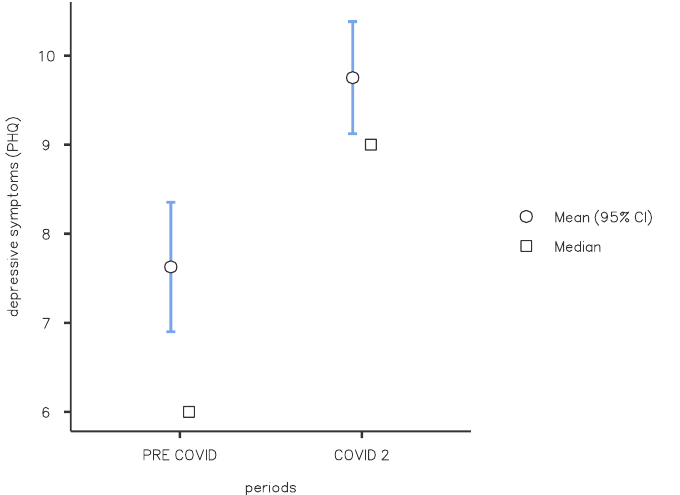
Figure 5. Depression symptoms: comparison of pre-COVID and COVID 2 periods. Mean score of the PHQ-9 questionnaire for the screening of depression symptoms. Significance between pre-COVID and COVID 2 groups ( p < 0.001).